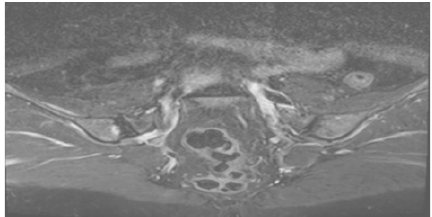
Figure 1: Signal enhancement consistent with the right iliac focal bone marrow edema adjacent to the right sacroiliac junction, T2 MRI sequences.